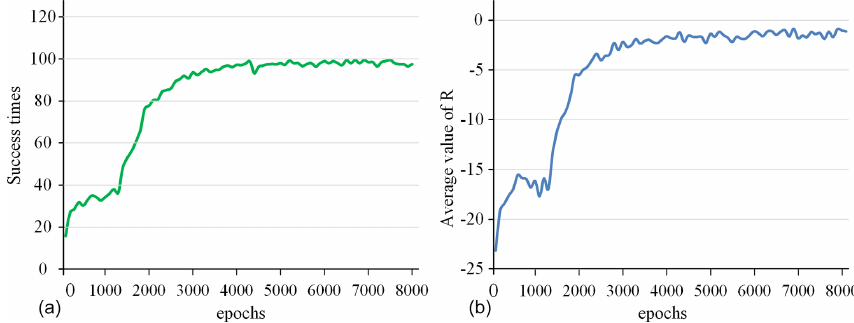
Figure 8. The success rate and the average value of R for all 100 epochs. (a) Success times per 100 epochs. (b) Average value of R per 100 epochs.